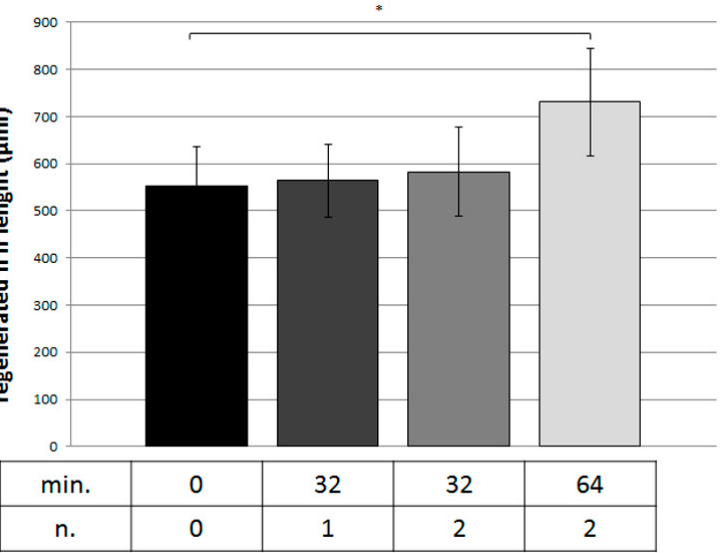
Figure 3. Regenerated fin rays’ length measurements in different treatment with HI LF-PEMFs. Parameters were expressed as minutes of treatment (min.) and number of daily sessions (n.) (0 vs. 64, * p < 0.05).